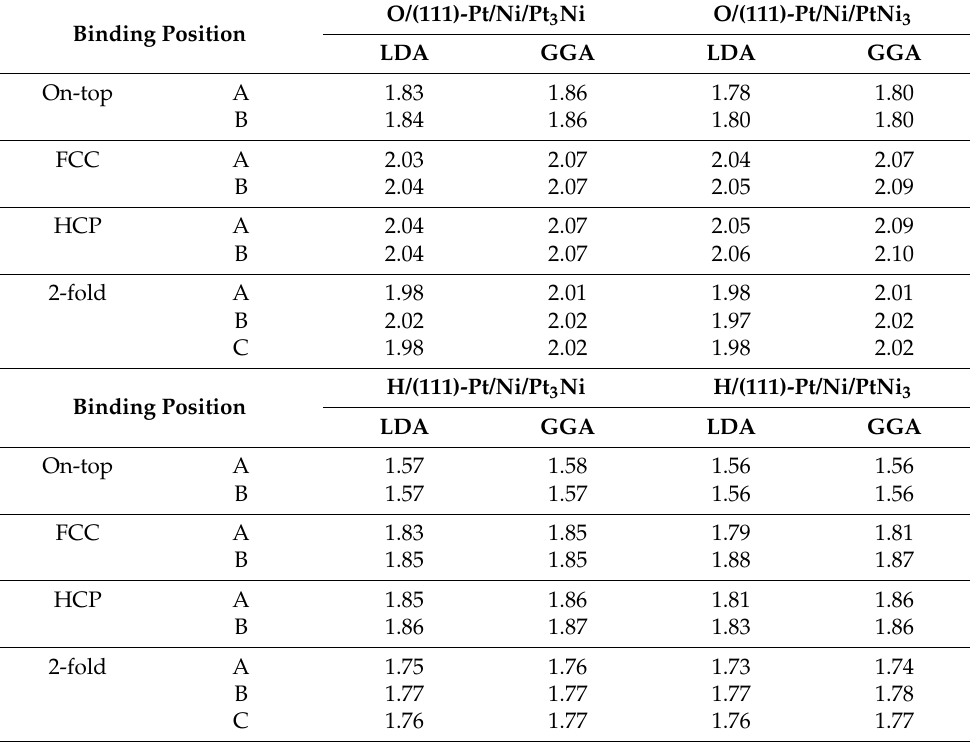
Table 6. Nearest-neighbour oxygen-Pt and hydrogen-Pt bond lengths on the high symmetry sites of the (111)-Pt/Ni/Pt 3 Ni and (111)-Pt/Ni/PtNi 3 surfaces. All the nearest-neighbour Pt atoms lie in the surface Pt layer. The binding positions are defined in Figure 14. The column subheadings (‘LDA’/‘GGA’) indicate the exchange-correlation functional used. All bond lengths are in Å. Binding